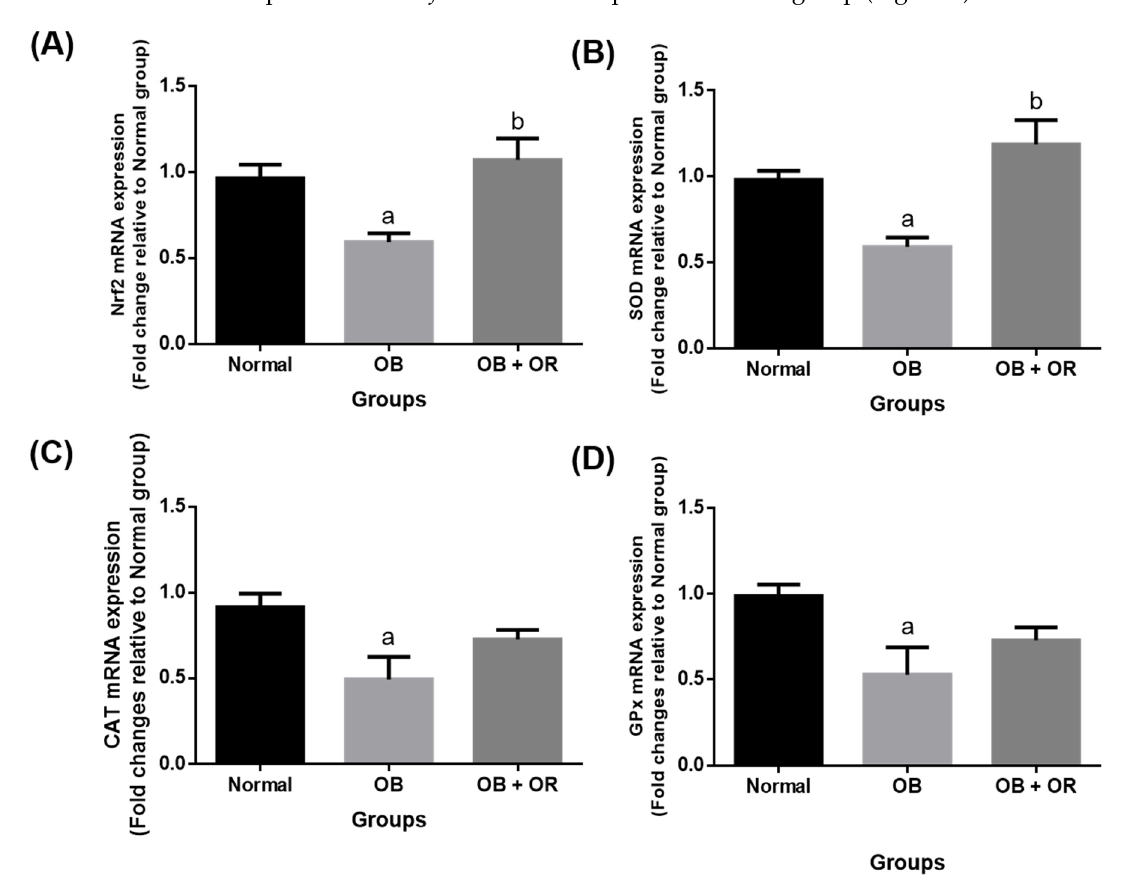
Figure 1. Cardiac mRNA expressions of ( A ) Nrf2 , ( B ) SOD , ( C ) CAT , and ( D ) GPx in Normal, OB (Obese control), and OB + OR (obese and orlistat 10 mg/kg/day) groups. Values are presented in mean and SEM, n = 6 rats per group. a p < 0.05 compared with Normal group, b p < 0.05 compared with OB group. Data were analyzed by One-way ANOVA followed by Tukey’s post-hoc test. CAT; catalase, GPx; glutathione peroxidase, Nrf2; nuclear factor erythroid factor-2, SOD; superoxide dismutase.